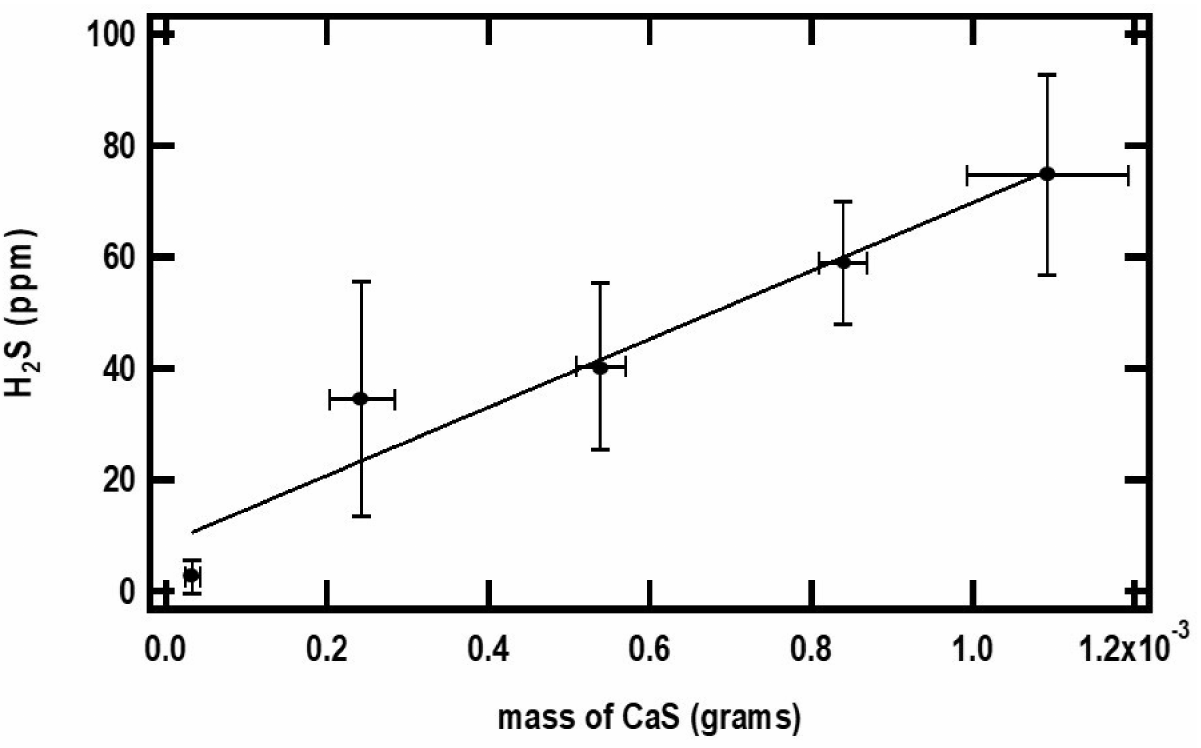
Figure 4. The small black dots in the figure represent the maximum amount of H 2 S detected (ppm) as a function of the initial amount of CaS(s). The error bars represent the standard deviation of at least three measurements with similar amounts of CaS(s). The pH of the acidic solution employed is 0.70. See text for details.